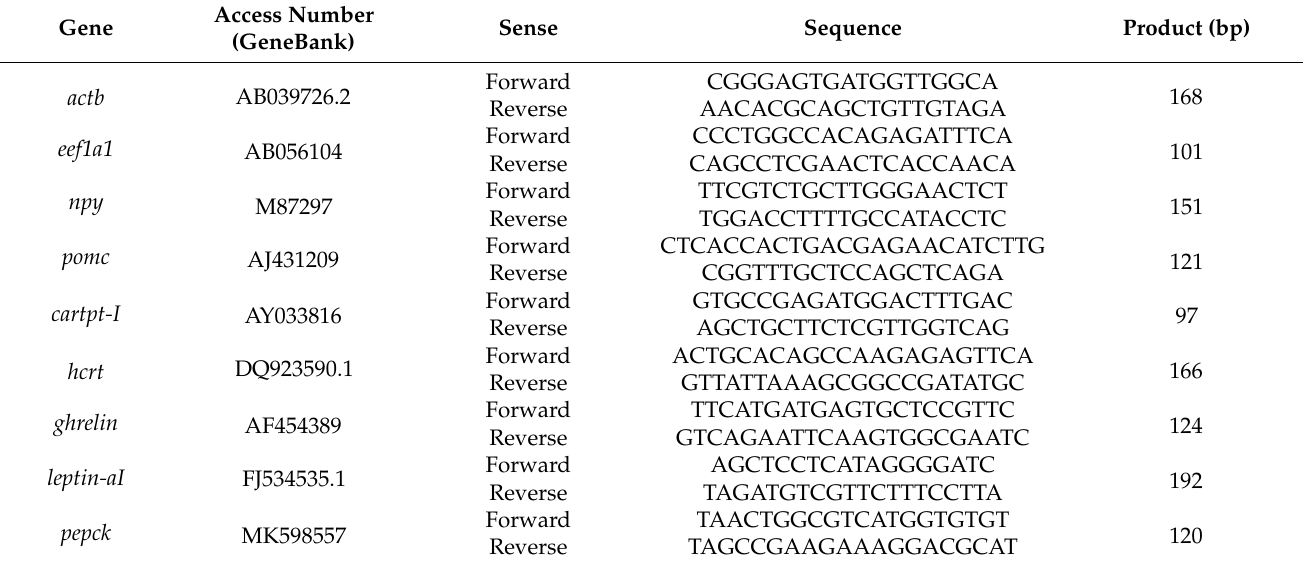
Table 1. Primers used in the RT-qPCR for housekeeping and target